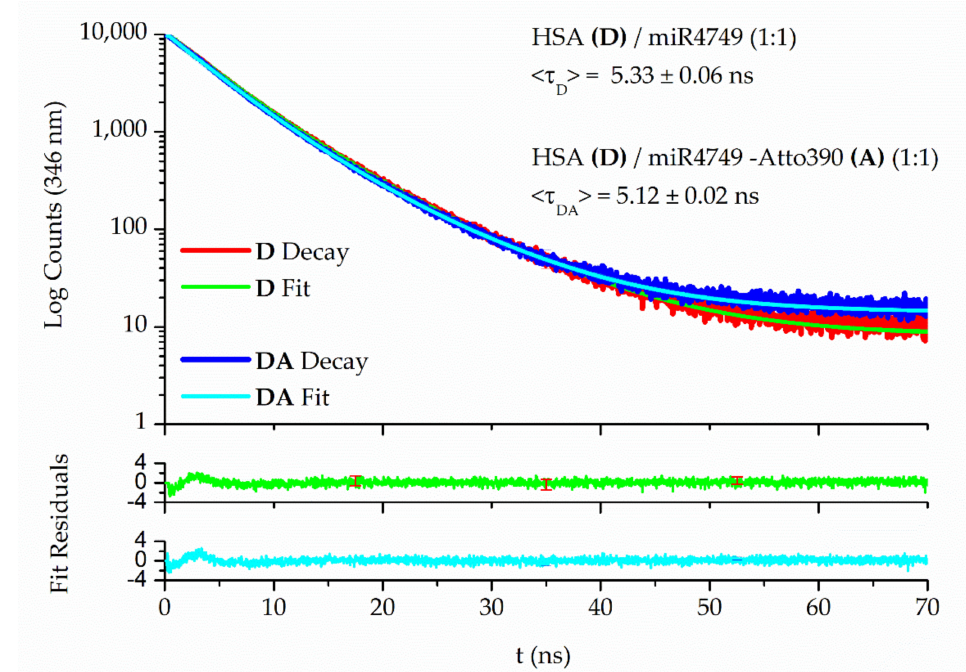
Figure 3. Fluorescence decays of 5 µ M HSA/miR4749 (D) and HSA/miR4749–Atto390 (DA) complexes in PBS buffer (pH 7.4), collected through the TC single-photon counting method; λ exc = 295 nm, λ em = 346 nm, at 298 K. The corresponding average fluorescence lifetimes, < τ and < τ DA >, are